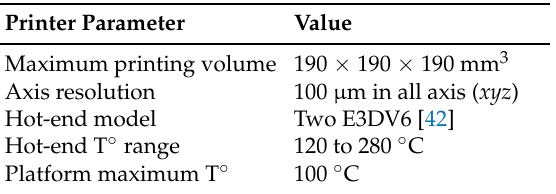
Table 2. Ocular3D EIE-custom 3D printer technical specifications.